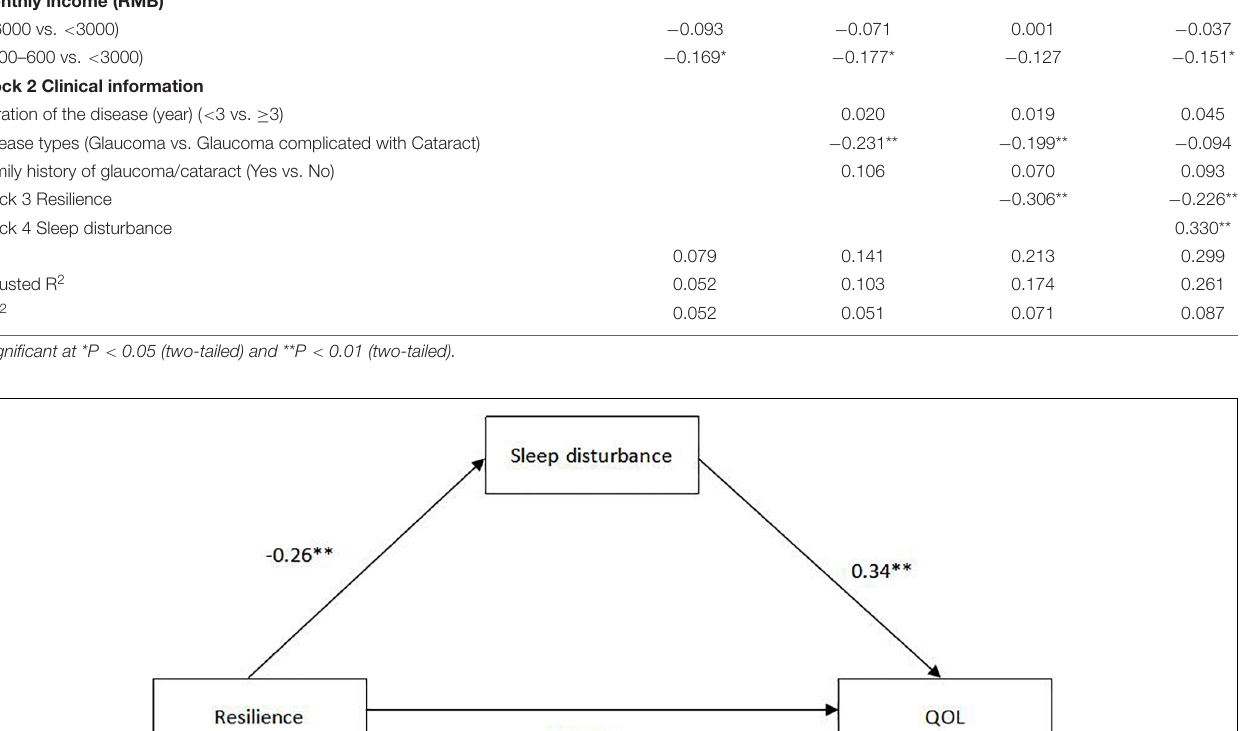
Frontiers in Medicine |